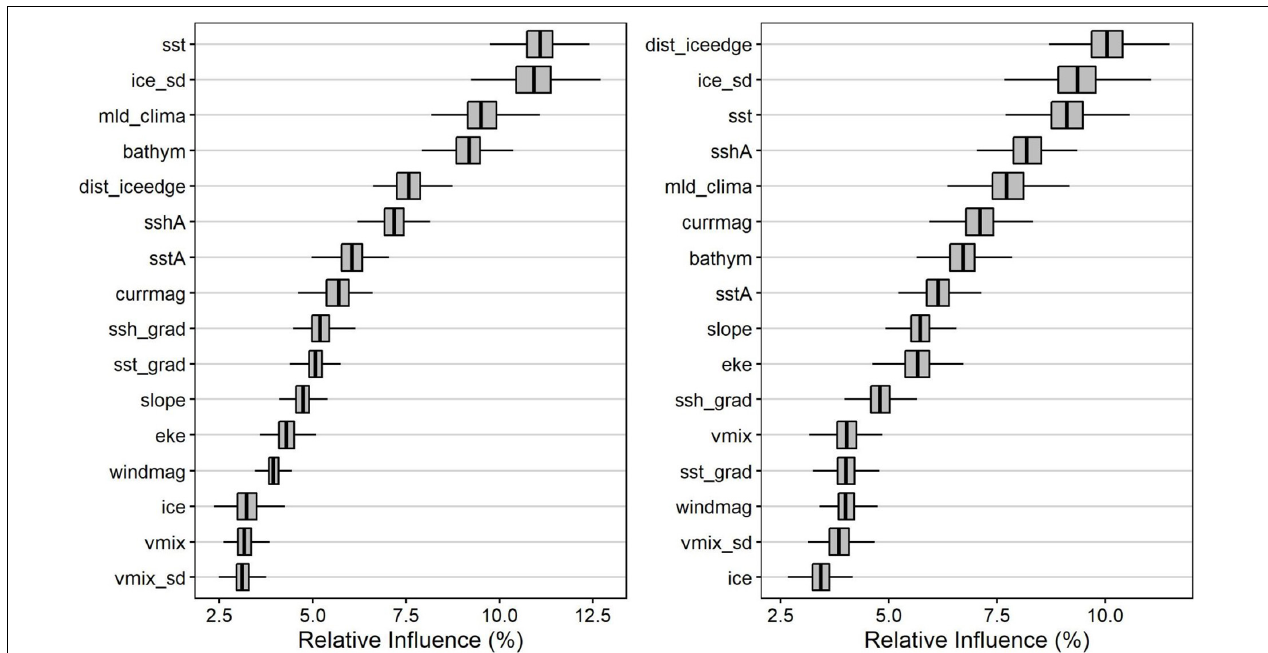
FIGURE 4 | Relative influence (%) for the 500 bootstraps of the environmental variables used in the habitat models during summer (A) and winter (B) of Ross seals tracked within the eastern Weddell Sea. Bathym, bathymetry; slope, slope of the sea floor; dist_iceedge, distance from the ice edge; eke, eddy kinetic energy; ice, sea ice concentration; ice_sd, ice concentration standard deviation; mld_clima, mixed layer depth climatology; sst, sea surface temperature; sshA, sea surface height anomaly; sstA, sea surface temperature anomaly; ssh_grad, sea surface height gradient; sst_grad, sea surface temperature gradient; vmix, vertical mixing speed; vmix_sd, vertical mixing speed standard deviation; currmag, current magnitude; windmag, wind